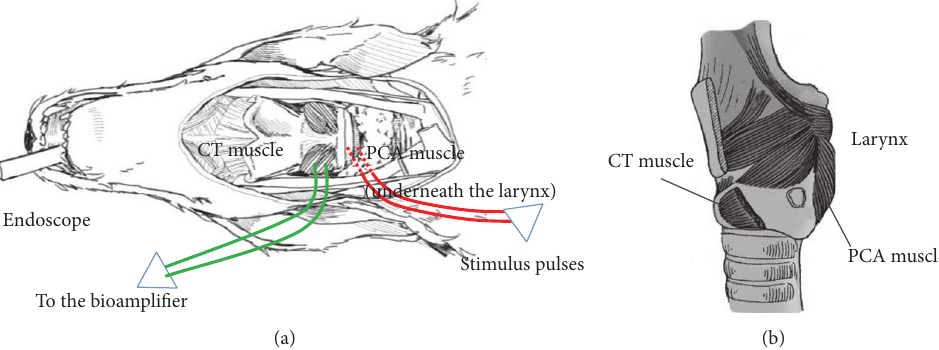
Figure 1: Schematic drawing of the surgical preparation. (a) Green wire shows the site where electrodes were inserted into the CT muscle to record the EMG signals. Red wire shows the site where the stimulus pulses were delivered into the PCA muscle. The dashed line section indicates that the wire is underneath the larynx. (b) The locations of CT muscle and PCA muscle.